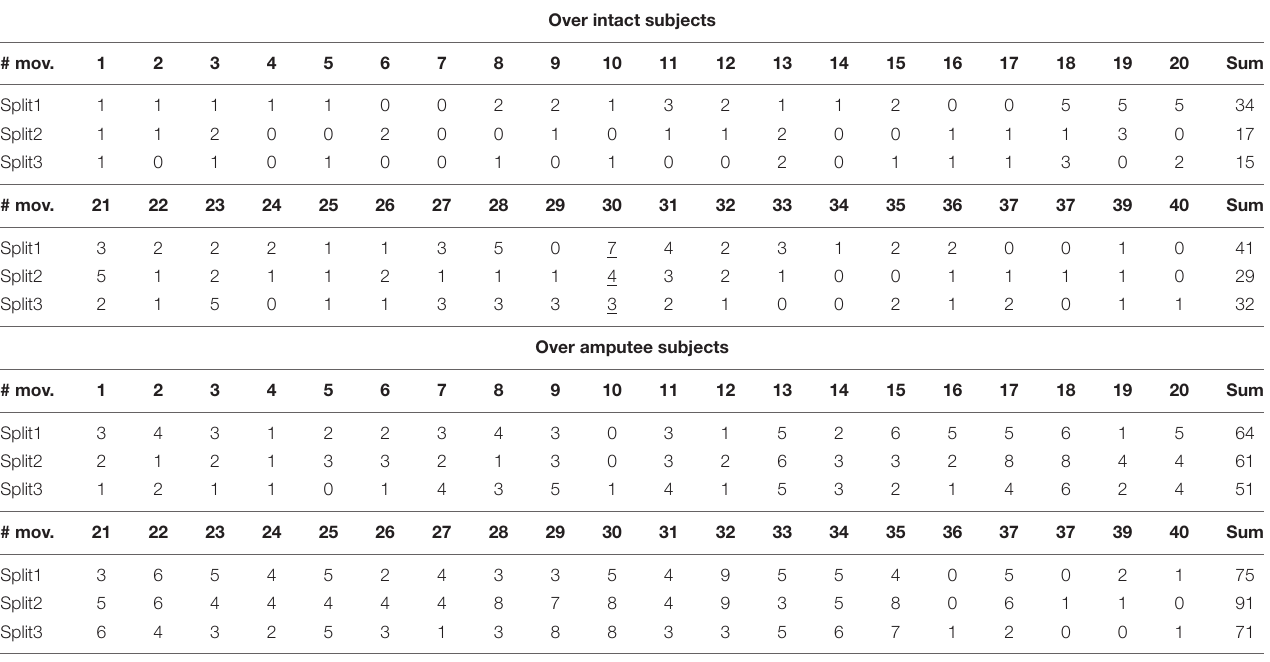
TABLE 1 | The number of misclassifications for each movement in each hold out repetition scenario.